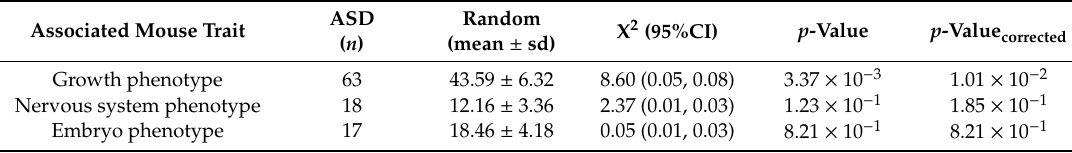
Table 2. Proportions of Autism Spectrum Disorder Genes Associated with Specific Top Level Mammalian